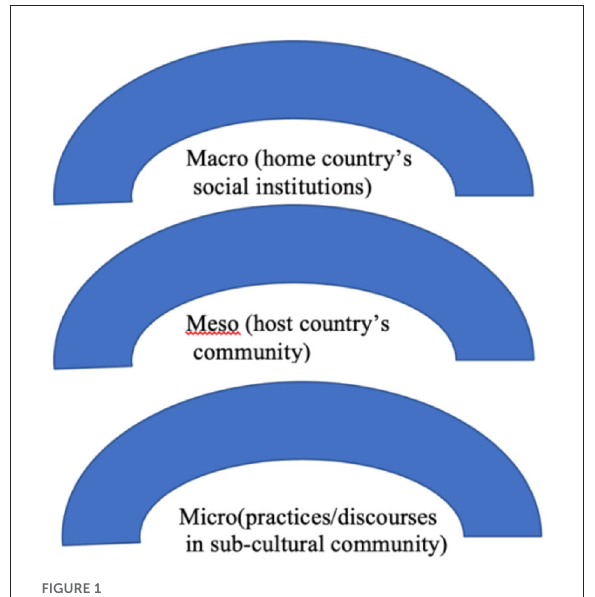
FIGURE1 The macro, meso, and micro levels of social conditions that shape and form queer people’s identity and